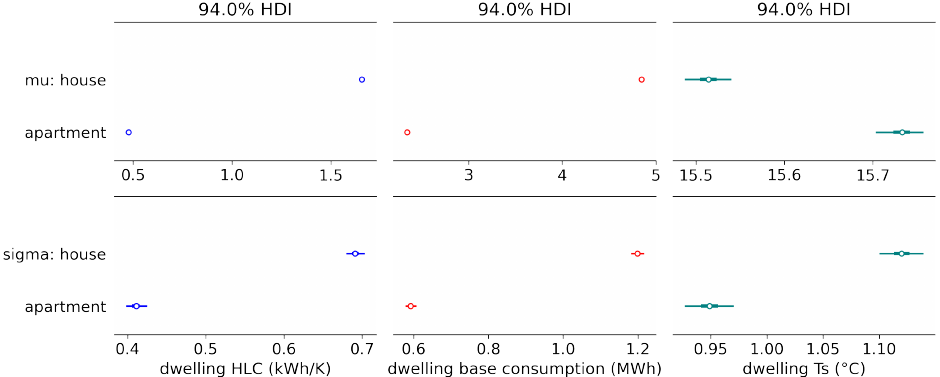
Figure 9. Inference results for houses and apartments model with 94% HDI (Highest Density Interval). Central points are for mean values and bold lines for inter-quartiles.